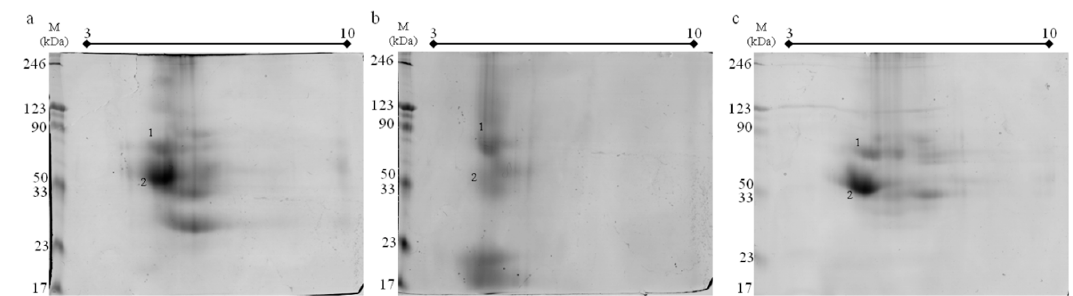
Figure 4. Gels obtained after 2D-PAGE electrophoresis of the: ( a ) black locust honey, ( b ) buckwheat honey, ( c ) rapeseed honey; 160 μ g of protein obtained from phenol extraction were loaded on each pH 3–10 IPG strip; M—protein molecular mass marker Roti ® -Mark PRESTAINED; 1-2—proteins identified using MS, numbers correspond with Table 2.